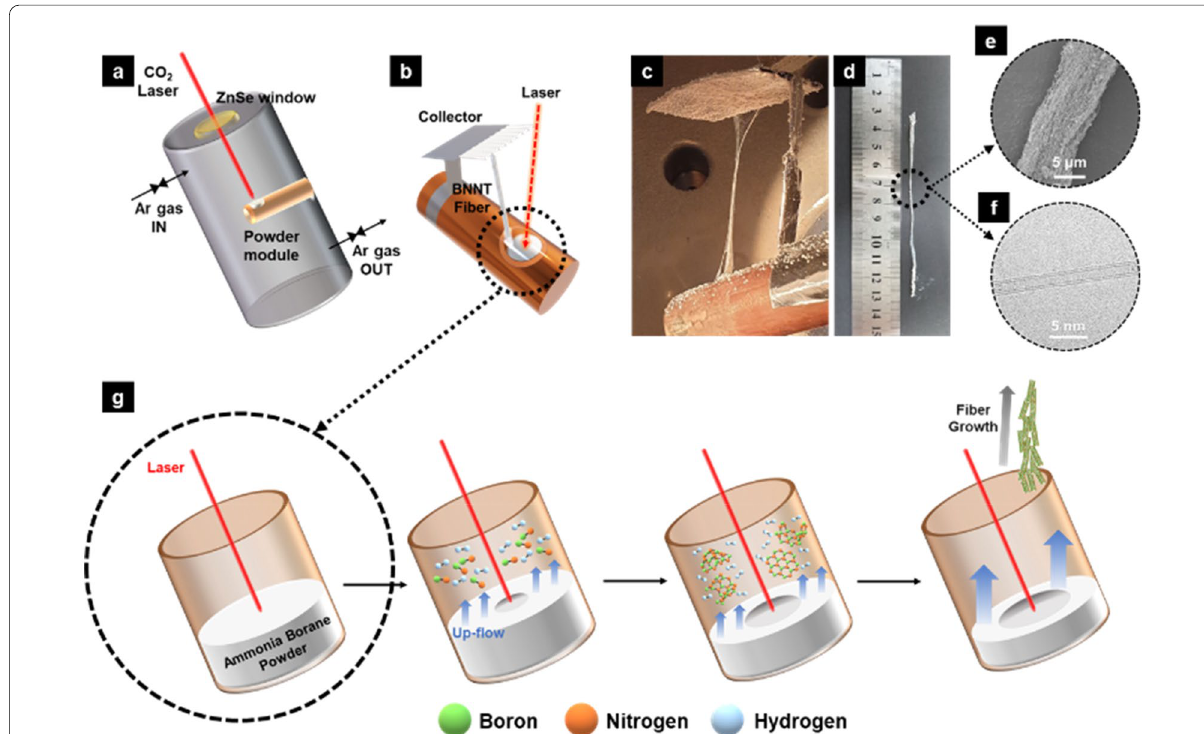
Fig. 2 Schematic diagram of ( a ) BNNT synthesis equipment and b powder module; c Obtained BNNT fiber right after the reaction; d 10 cm long BNNT fiber; e SEM image of the BNNT fiber; f TEM image of the BNNT; g Schematic diagram of synthesis